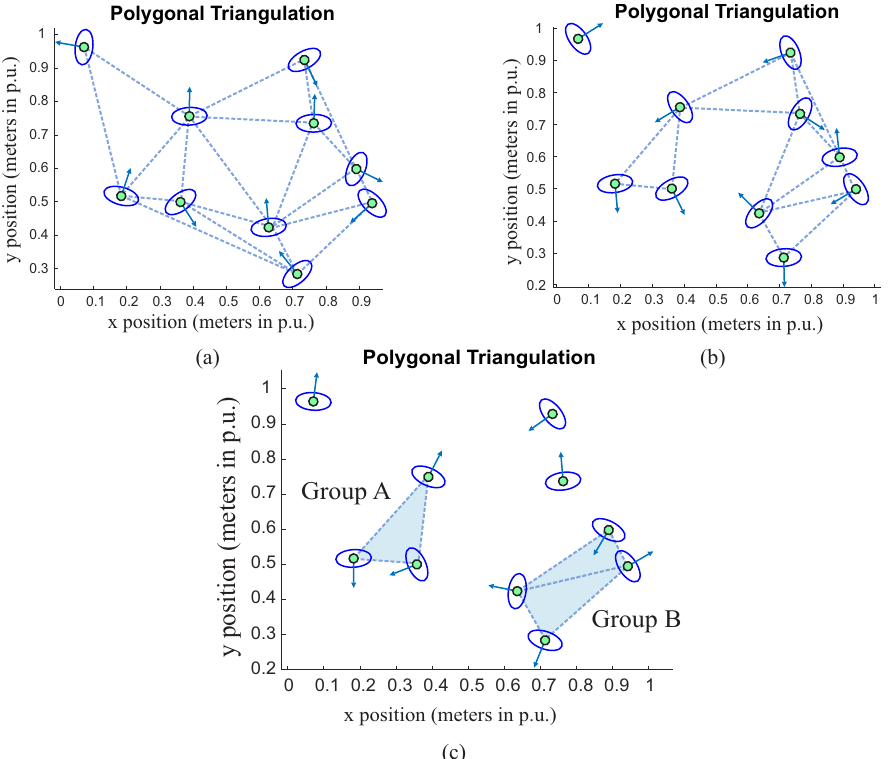
Figure 11. Group classification by using Delaunay triangulation. ( a ) Without limit of distance, ( b ) with distance limitation d max = 0.40 p . u . and ( c ) with distance limitation d max = 0.32 p . u . Blue triangles mean the resulting groups (Group A and